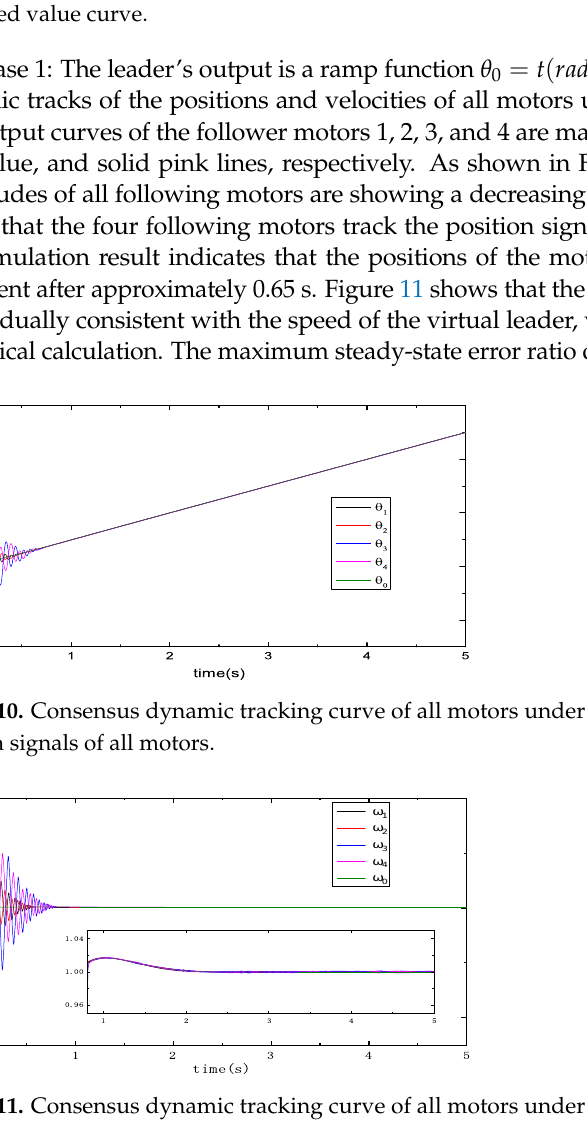
Figure 11. Consensus dynamic tracking curve of all motors under the reference signal θ 0 = t ( rad ) : velocity signals of all